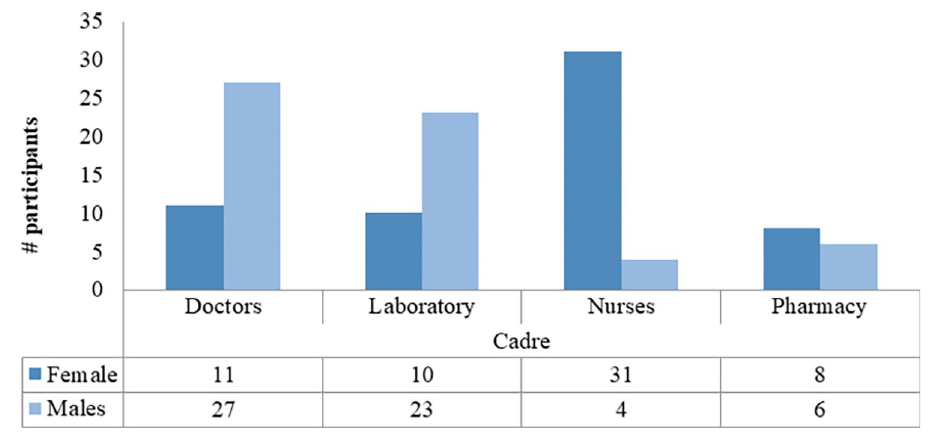
Fig 3. Gender variation for each cadre.